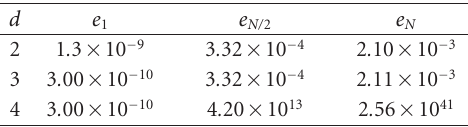
Table 6.2. Approximate error for Example 6.2.